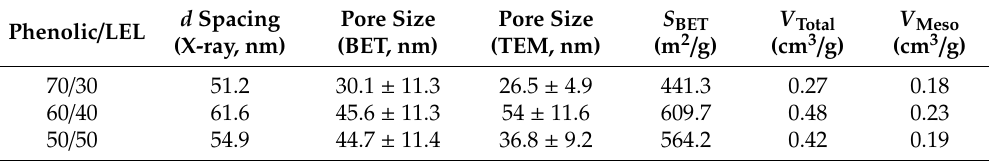
Figure 5. ( a ) N 2 adsorption isotherms and ( b ) pore size distributions of mesoporous carbons templated by various concentrations of LEL triblock copolymer. Table 1. Physical properties of ultra-large mesoporous carbons templated by phenolic / PLA- b -PEO- b -PLA